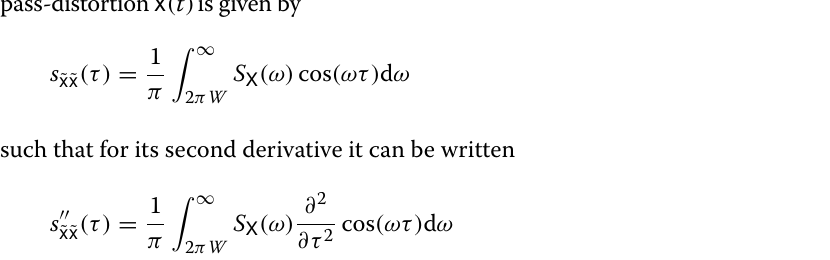
g ( t 1 T l ) . The ISI ˆ − − | l �= k